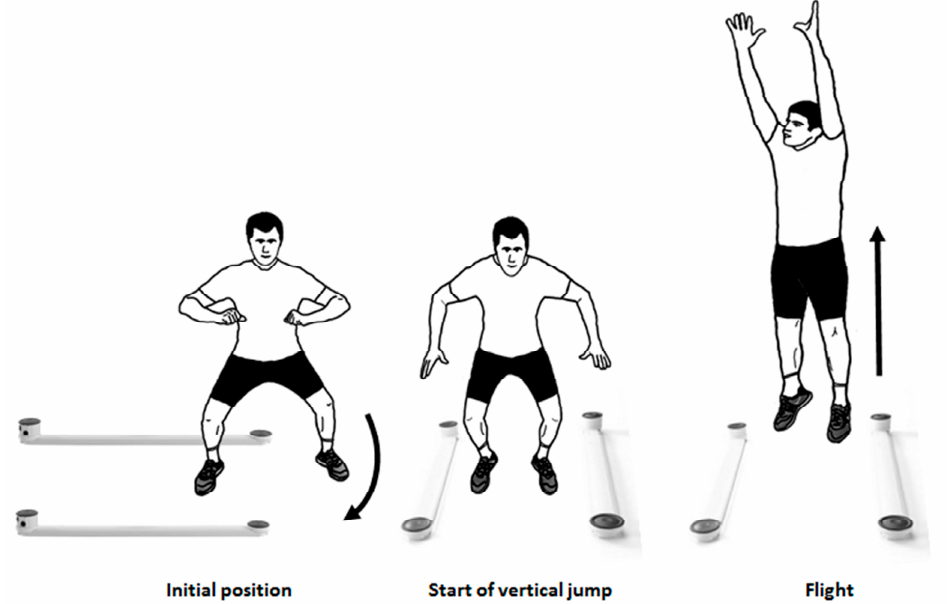
Figure 2. Graphical representation of the design of the study.